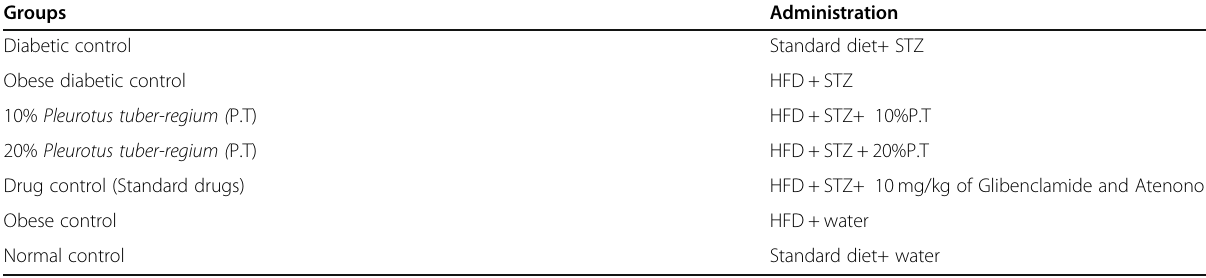
Table 2 Experimental design, diet and drug administered